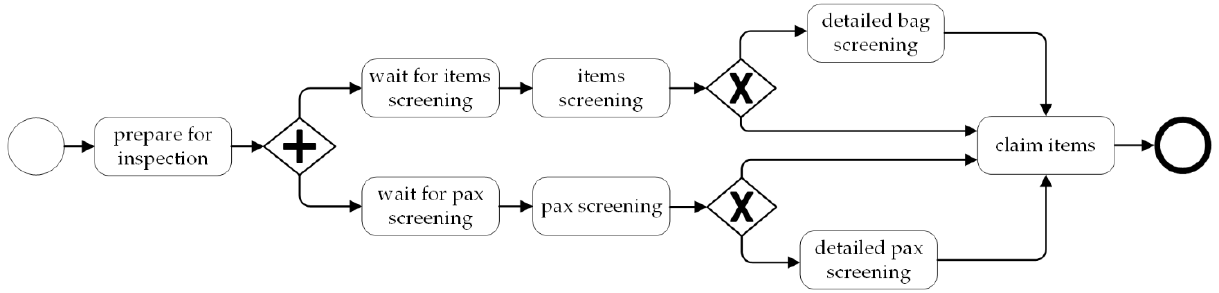
Figure 3. Simplified algorithm for passenger and baggage flow.